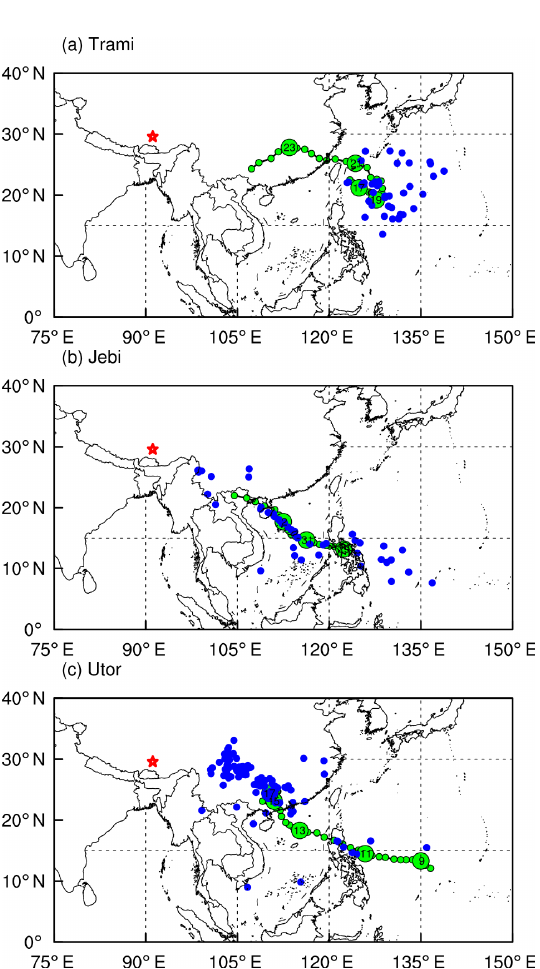
Figure 2. Pathways of tropical cyclones (a) Trami, (b) Jebi, and (c) Utor are marked as green dots for every 6h. The number printed inside the large green dots indicates the day in August 2013, except 29 and 31 in (b) , which refer to 29 and 31 July. The blue points denote the average geographical position where air parcels experi- enced strong uplift within tropical cyclones. The red star marks the location of Lhasa. Three profiles highlighted in bold in Table 1 (11, 19, and and will be discussed in detail in Sect.